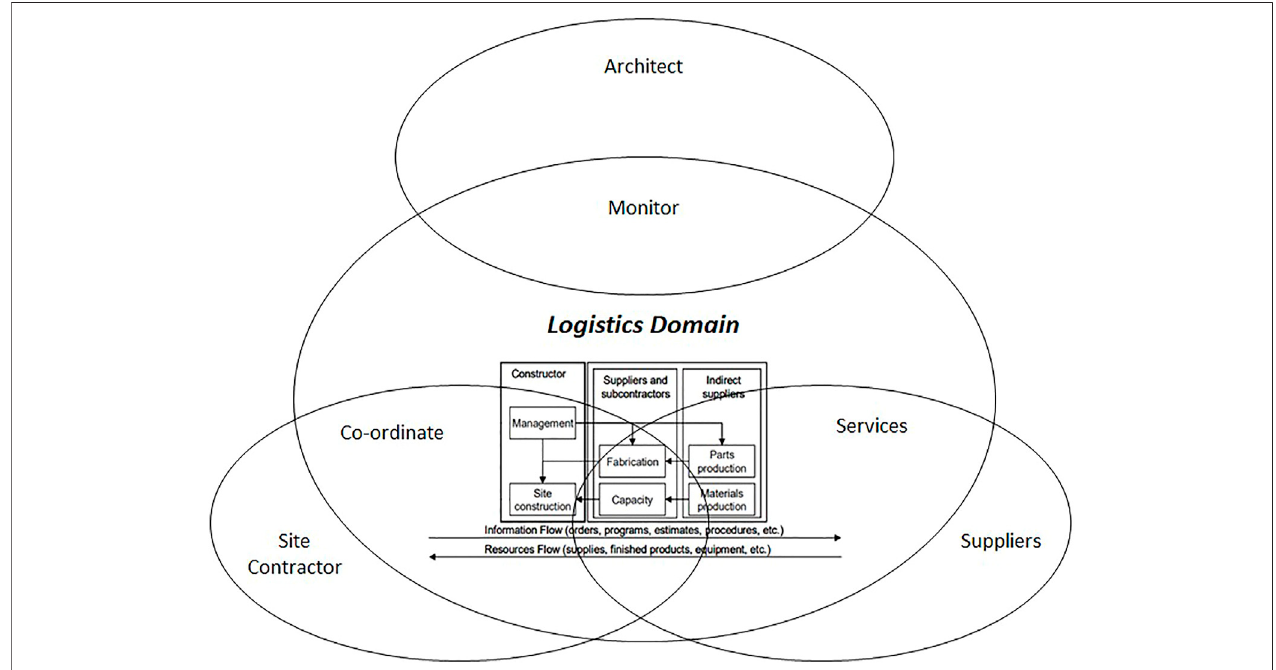
FIGURE 2 | The Construction Logistics domain (Authors ’ conception based on Vrijhoef and Koskela, 2000; Salagnac and Yacine, 1999).